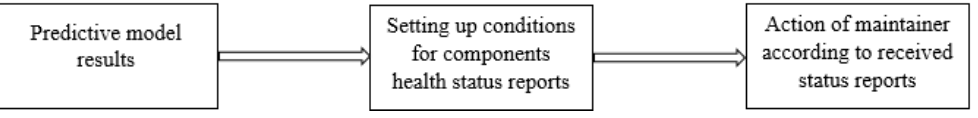
Figure 16. Process to maintenance